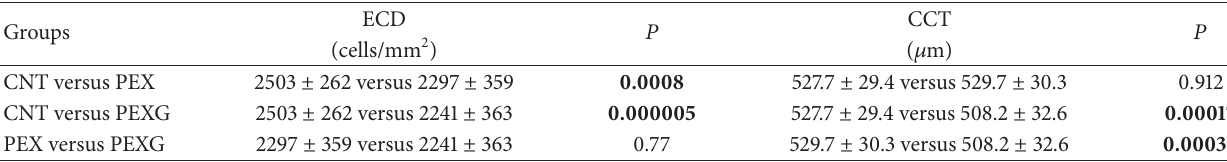
Table 2: Summary of results.